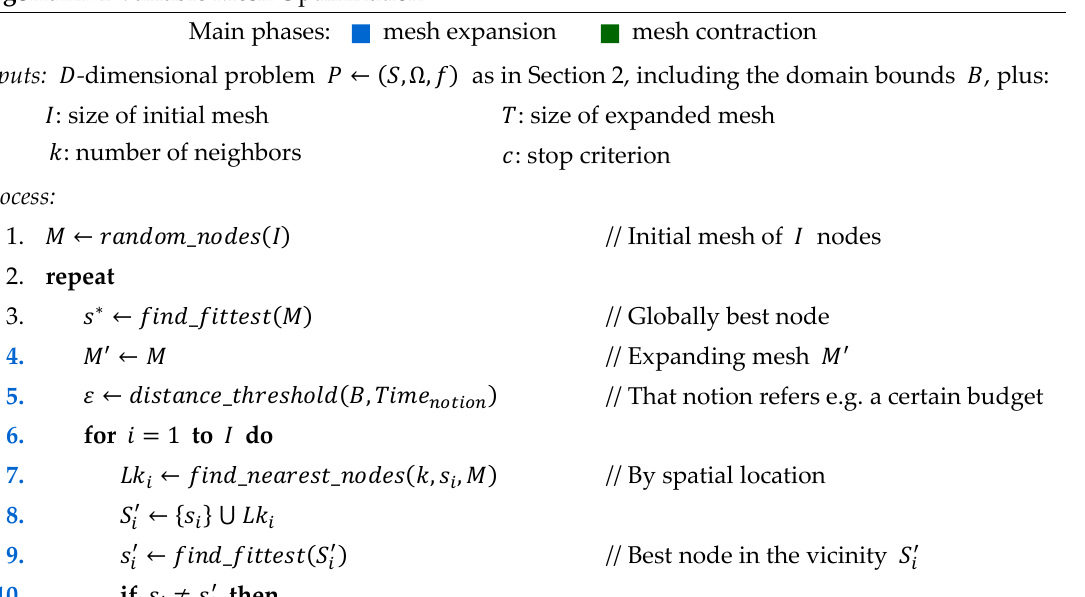
Algorithm 1 Variable Mesh